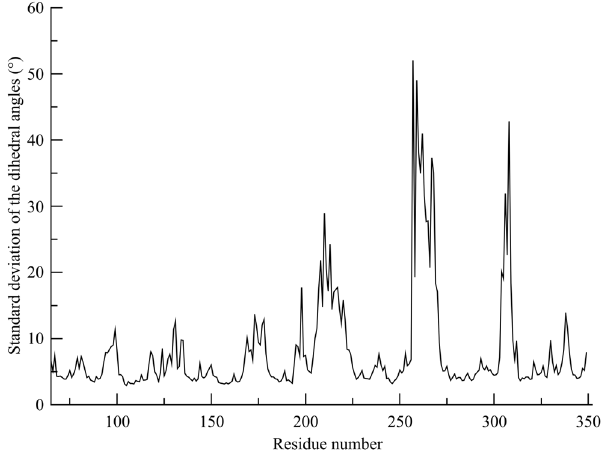
Fig. 4. Standard deviation of the mean dihedral angles calculated from the 0.5 m s all-atom MD production between four consecutives C a atoms along the m OR backbone.